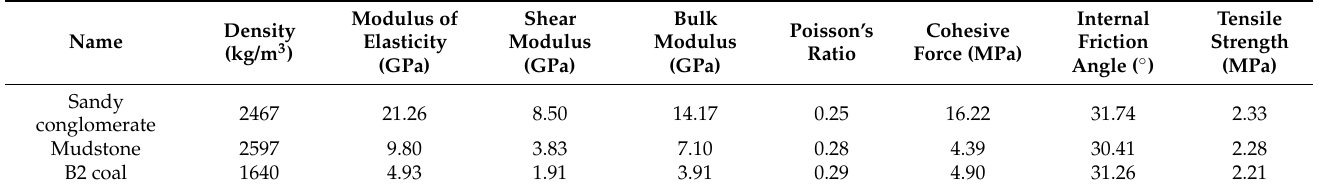
Table 1. Physical and mechanical parameters of the roof and coal seam.